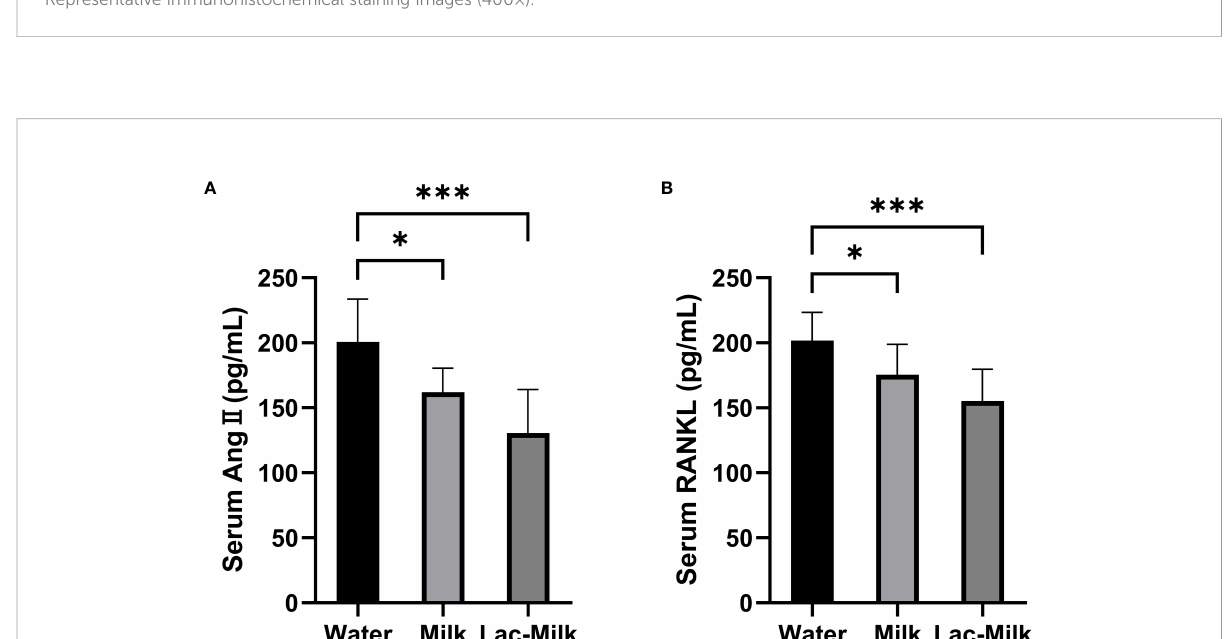
FIGURE 9 Comparison of serum Ang II and RANKL levels in the water and milk groups with the Lactobacillus casei fermented milk group. (A) Serum angiotensin II (Ang II); (B) Receptor Activator for Nuclear Factor- k B Ligand (RANKL). *p<0.05,